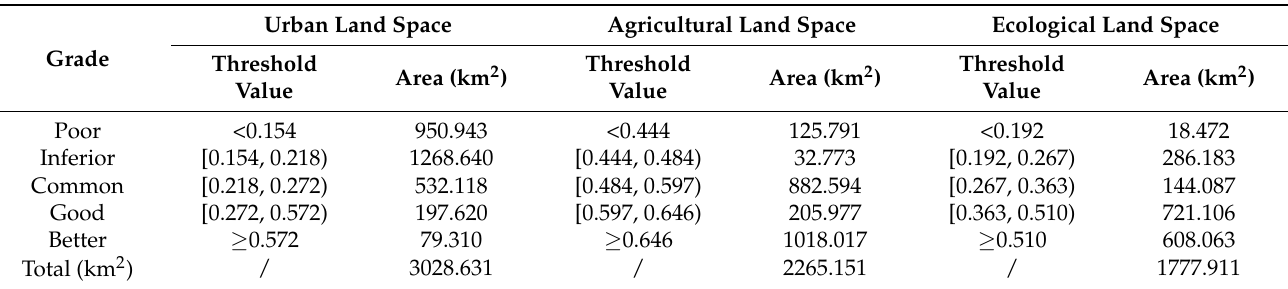
Figure 4. Carrying capacity grades of the three subspaces in Shanghai. Table 5. The interval values and areas of grades in the three